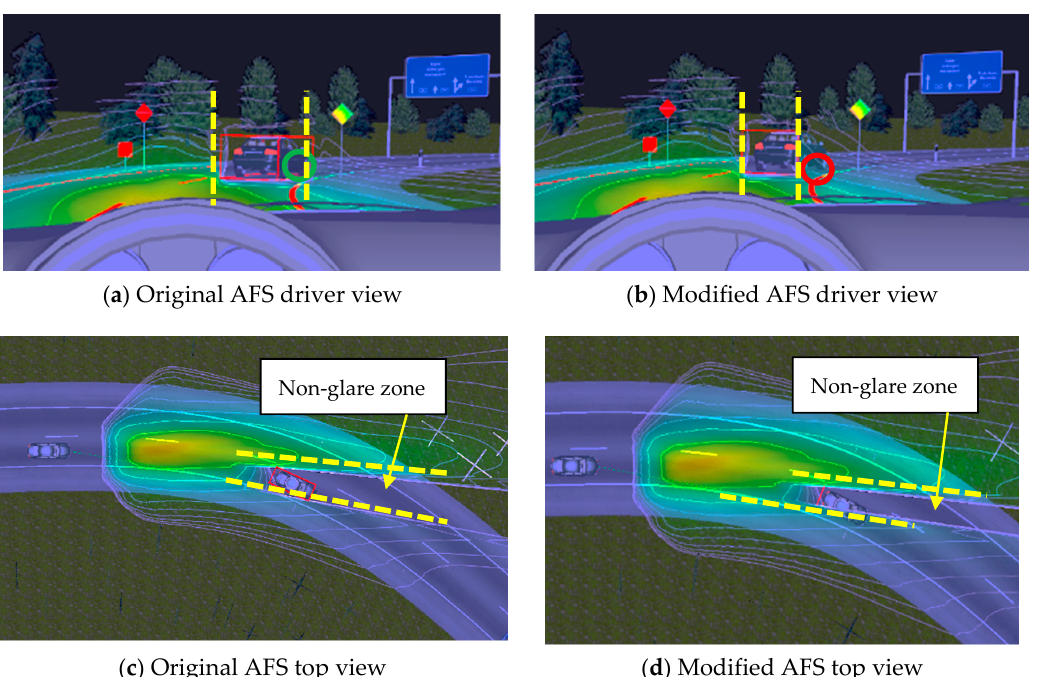
Figure 3. A graphical comparison in the simulator between the original and the modified ADB simulation, in which the non-glare zone is set at 100% and all parameters are identical. The red lines around the stimulus vehicle represent the boundary box: ( a , c ) The original ADB simulation in which the three-dimensional boundary box is recognized, and, thus, the entire vehicle geometry is covered by the non-glare zone. The modification in ( b , d ) simulates a more realistic ADB, in which only the taillight is recognized; thus, in top view ( d ), it is just a line at the rear of the stimulus vehicle. The non-glare zone is highlighted with yellow dashed lines showing that, with the modification, the side rearview mirror will be excluded from the boundary box during the cornering maneuver. The comparison shows that the simulator’s modified AFS plug-in can reproduce the glare